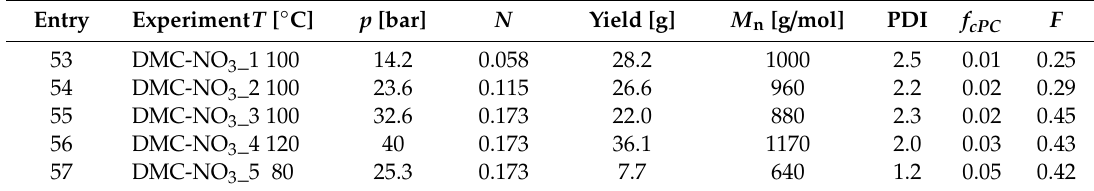
Table 10. Copolymerization mediated by DMC-NO 3